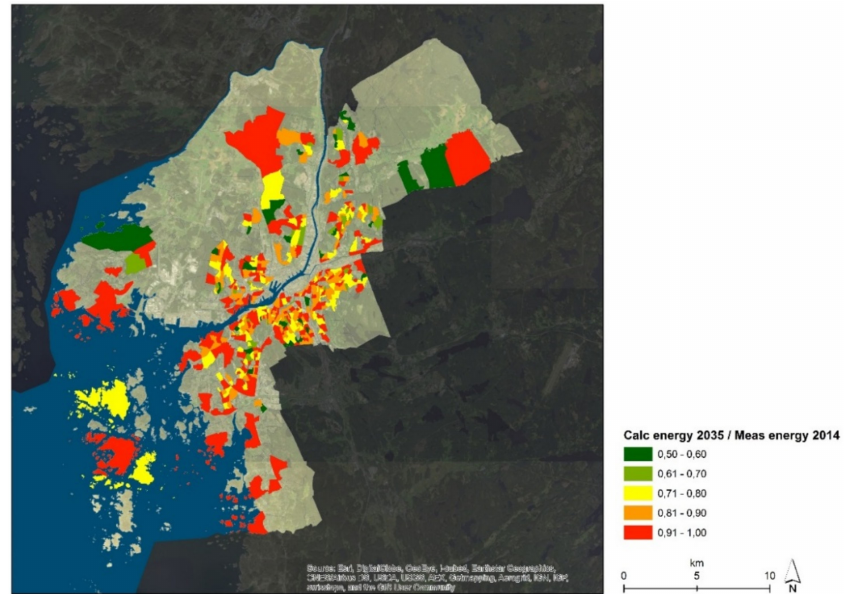
Figure 8. Reduction of energy demand until 2035 for base areas based on renovations in the existing stock as a fraction of current energy use.